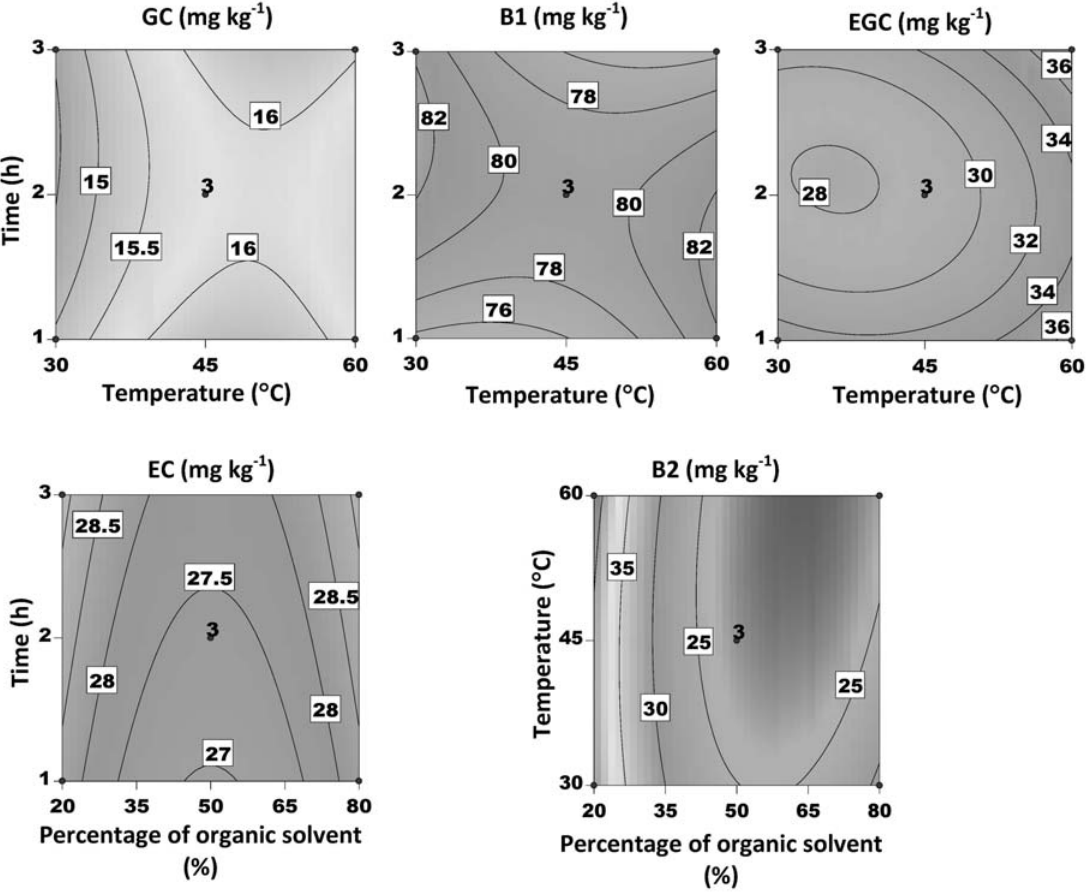
Fig. 4. Contour plots of most prominent interaction factors for individual flavan-3-ols from grape skins using acetonitrile as organic modifier. EC – Epicatechin; EGC – Epigallocatechin; GC – Gallocatechin; B1 –Procyanidin B1; B2 – Procyanidin